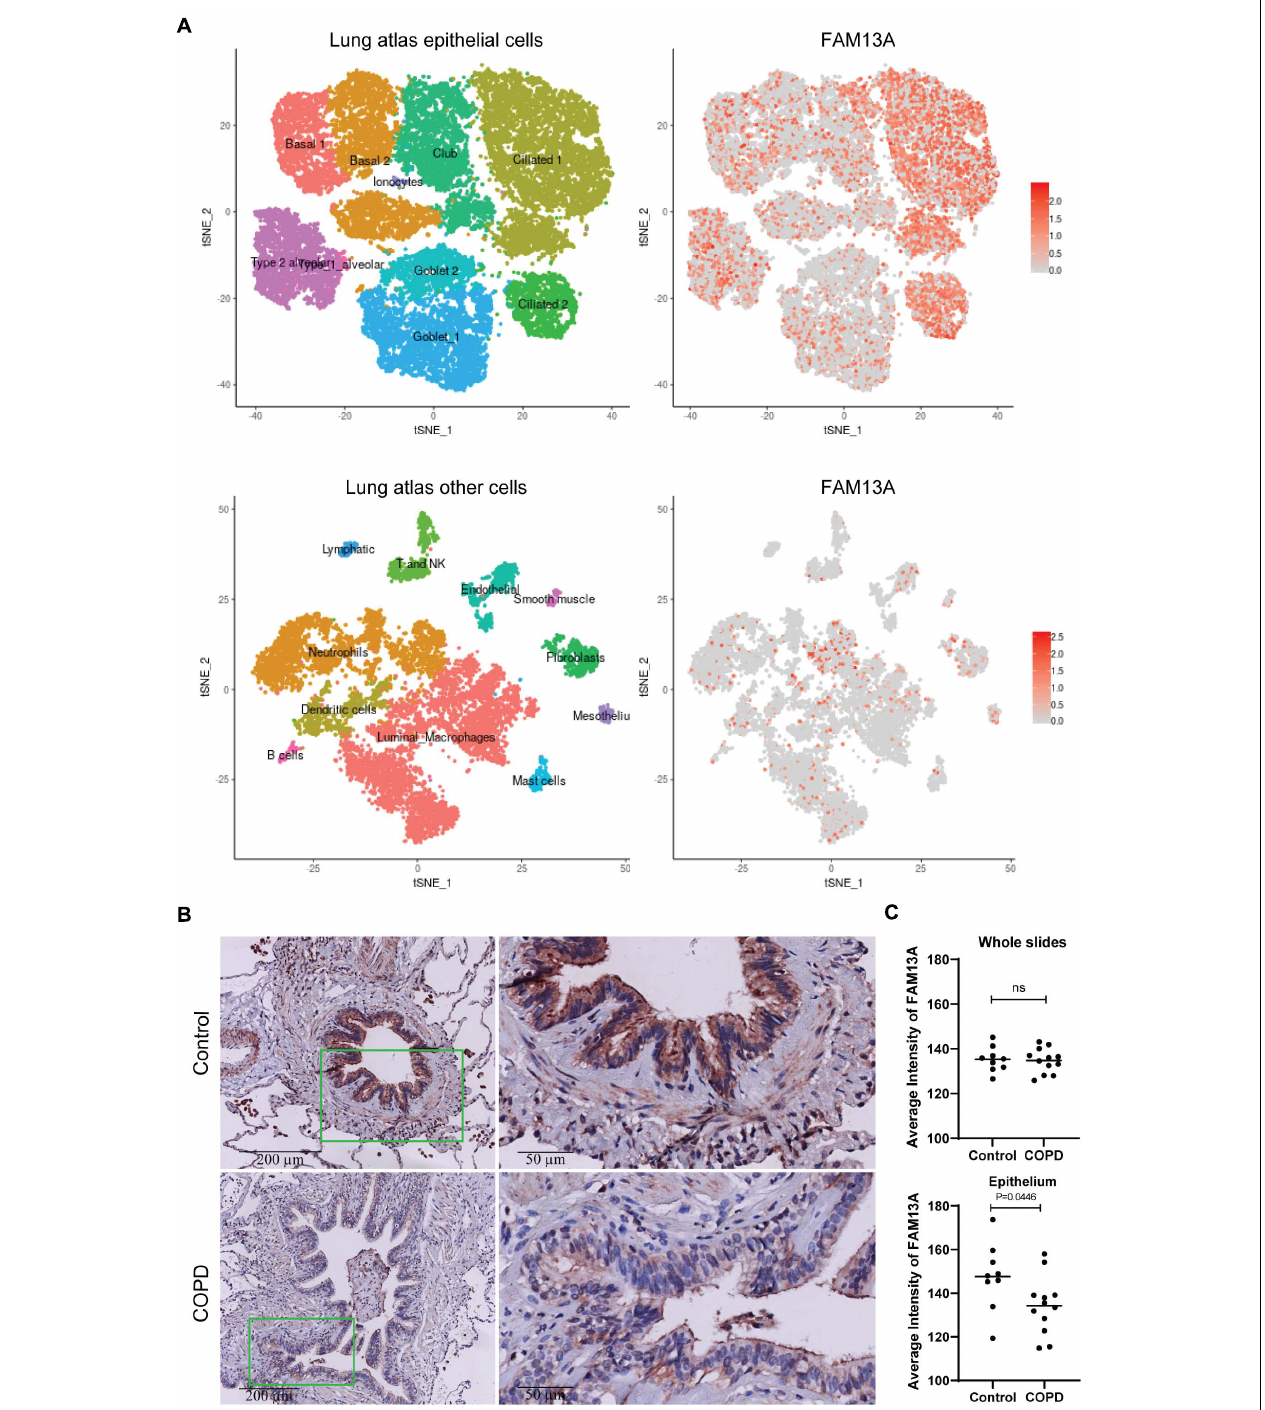
FIGURE 1 | FAM13A protein expression in human lung tissue. (A) Expression of FAM13A in single cell RNA sequencing data of airway epithelial cells. The figure in the upper left corner shows the different clusters of airway epithelial cells. The red dots on the right figures indicate the expression of FAM13A in the different clusters of the lung cells. Figures in the lower panel show the non-epithelial cell clusters and the FAM13A expression among these clusters. (B) FAM13A expression in whole lung tissue and in airway epithelial cells was assessed in 9 non-COPD controls (top) and 12 COPD patients (bottom) by immunohistochemistry (IHC). Representative images are shown. (C) Intensity of FAM13A in the whole slide and in the epithelium of every airway in the tissue. The average intensity of all airways per donor is presented. Each dot represents one subject. Data are shown as mean. Significant differences were assessed by Unpaired t -test and p -value is indicated.